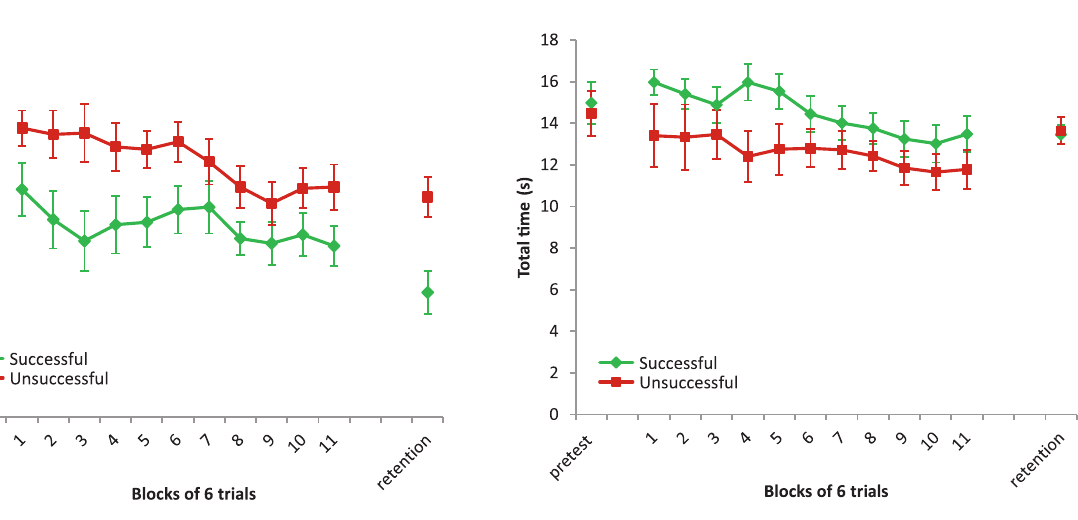
Figure 3. Total time (mean ± SD ) in the task of line tracking for each of the experimental conditions.